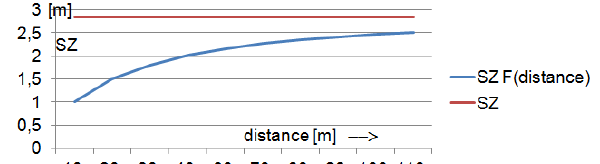
Fig. 20: Standard deviation of neighbored points as function of point distance for WorldDEM – relative accuracy